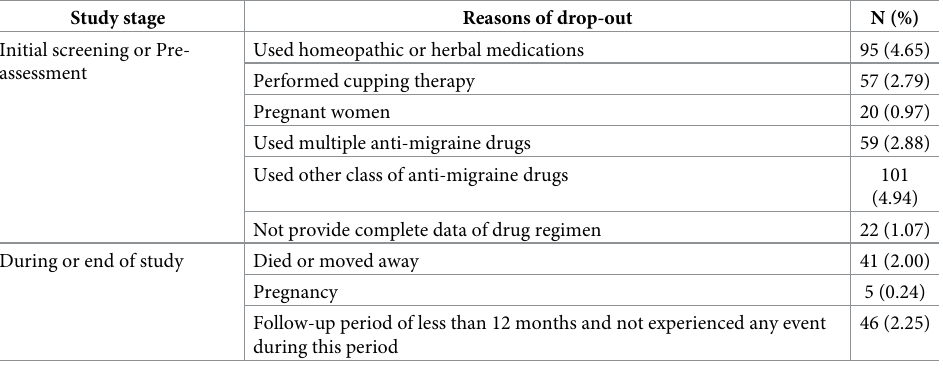
Table 1. Summary of dropout patients with reasons at different stages of